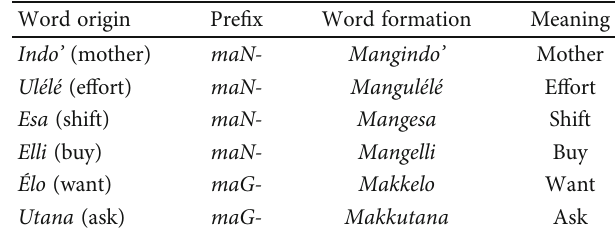
Table 1: Word formation with pre fi x ma- in Bugis language.